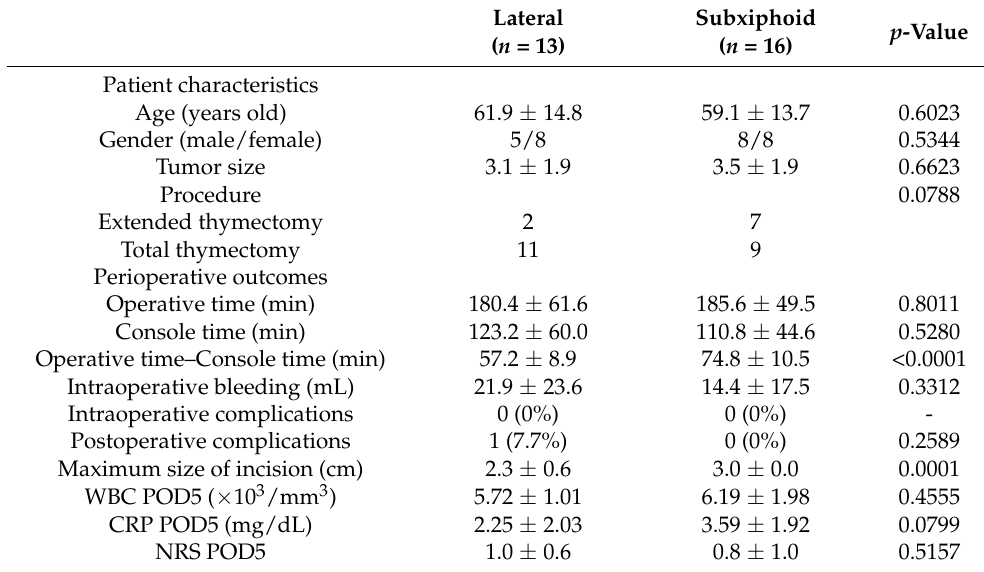
Table 1. Experience of robotic thymectomy using the lateral approach and subxiphoid approach.